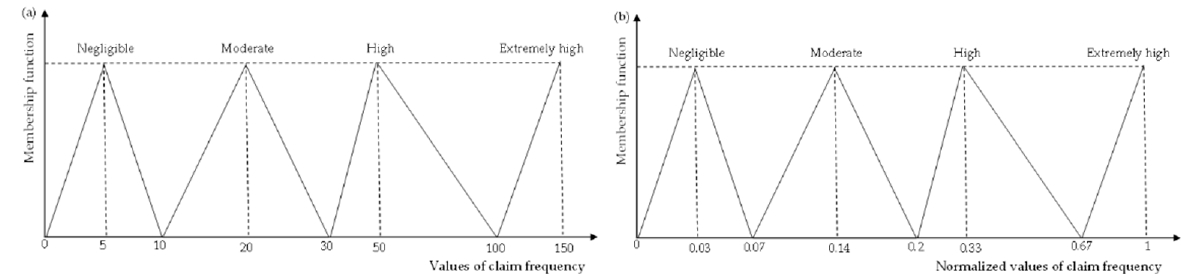
Figure 5. Linguistic forms for describing ( a ) the claim frequency and ( b ) corresponding the normal- ized TFNs.